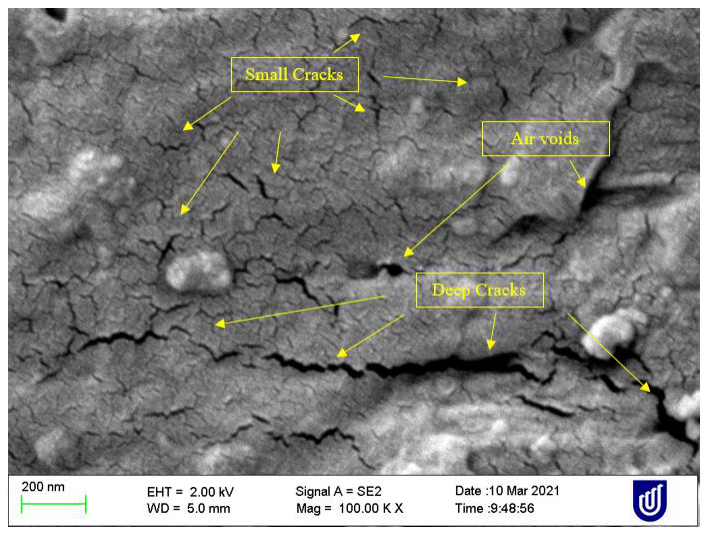
Figure 5. Scanning electron microscope image of plastic surface.